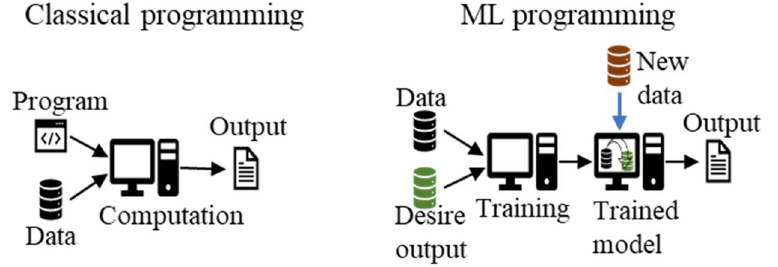
Figure 2. ML versus analytical approach in programming.